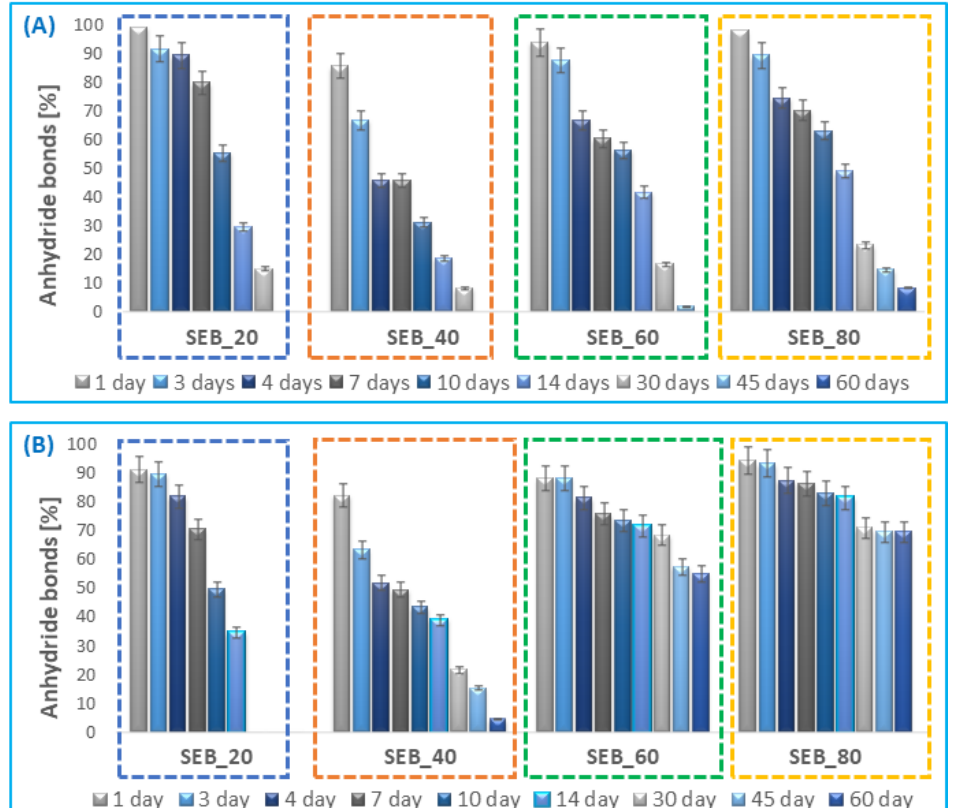
Figure 5. Anhydride bond loss of DBB-SEB polyanhydrides, for DBB segments ( A ) and SA segments ( B ) in the air at 25 °C ( n = 3, error bars, standard deviation).